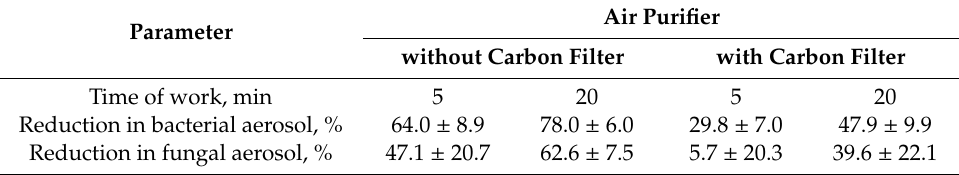
Table 4. The average e ffi ciency of air purifier with and without carbon filter ( n =